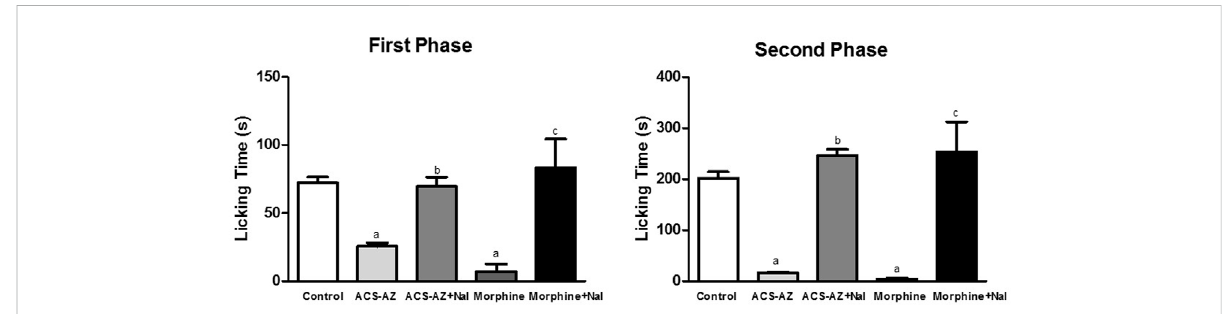
FIGURE 10 Effect of pretreatment with naloxone (5 mg/kg) on antinociception induced by ACS-AZ (50 mg/kg) or morphine (6 mg/kg) at the fi rst and second phases of the formalin-induced nociception. The lick time (seconds) after administration of formalin solution into the mice dorsal surface of therighthindpawwasrecorded foreachanimal.Theresultsrepresentthemean±SEM( n =8)analyzed byone-wayANOVAfollowedbyTukeytest: a p < 0.05vs. control; b p < 0.05vs. groupthatreceived onlyACS-AZ; c p < 0.05vs.groupthat receivedonlymorphine. ACS-AZ:N ’ -(6-chloro-2-